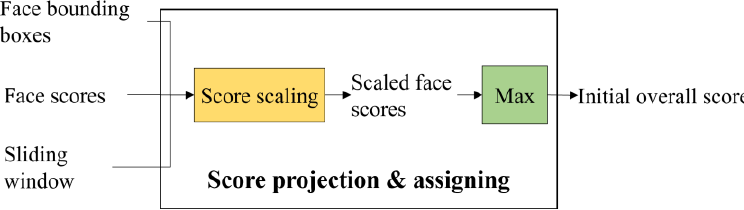
Figure 11. Diagram of the score projection and assigning module. Note that the filtered face infor- mation is fed into this module. The output initial overall score is assigned to the corresponding input sliding window.